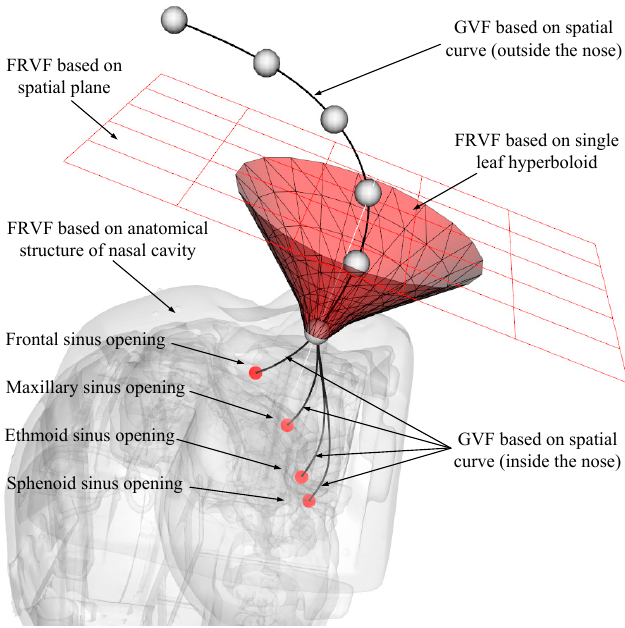
Figure 5. Overall robot motion constraint model based on VFs.